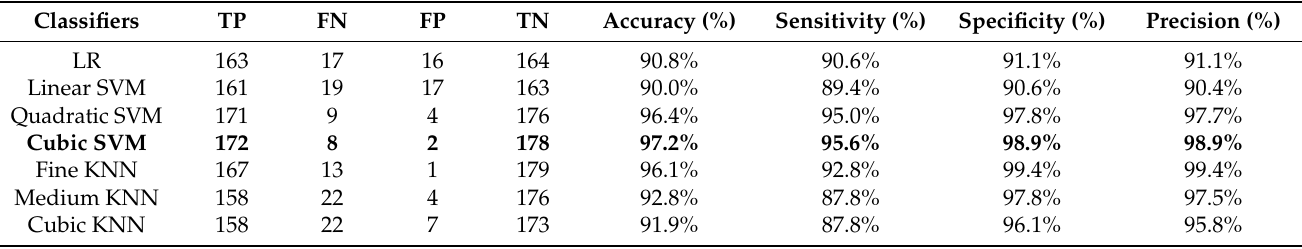
Figure 4. 3D confusion matrices for SampEn feature approach using multiple machine learning algorithms: ( a ) LR; ( b ) linear SVM; ( c ) quadratic SVM; ( d ) cubic SVM; ( e ) fine KNN; ( f ) medium KNN; ( g ) cubic KNN. Table 1. Performance analysis of the KNN, SVM, and LR machine learning algorithms on the testing dataset (The best performance result is indicated in bold).